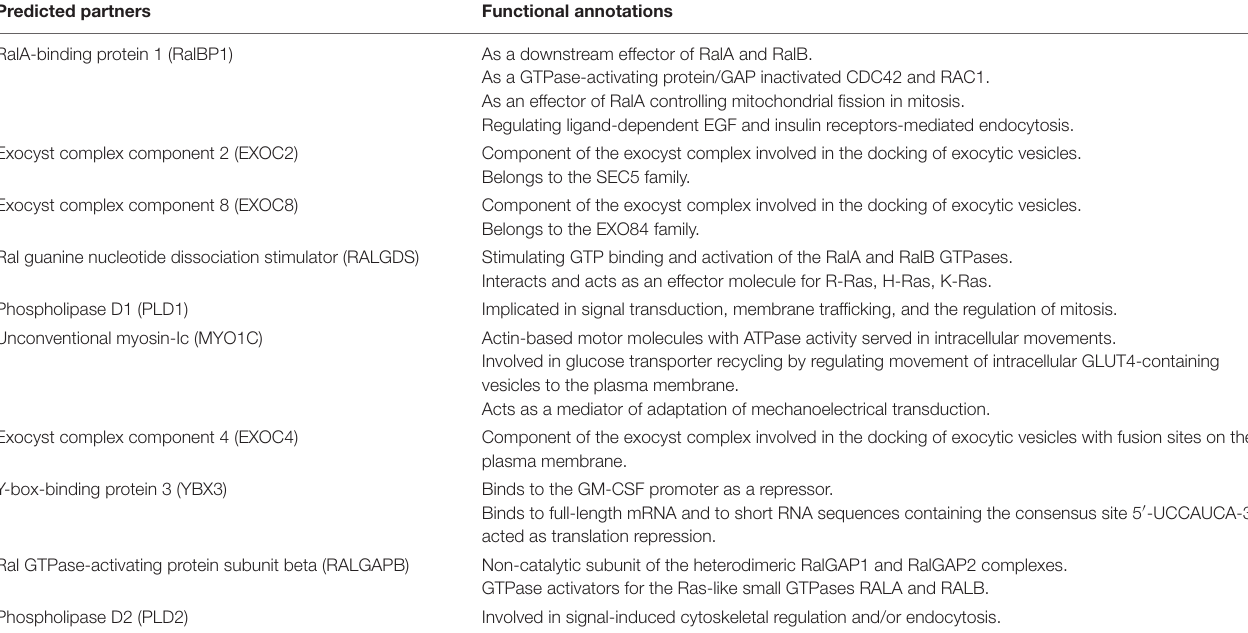
TABLE 1 | A list of the top 10 proteins interacting with RalA. Predicted partners Functional